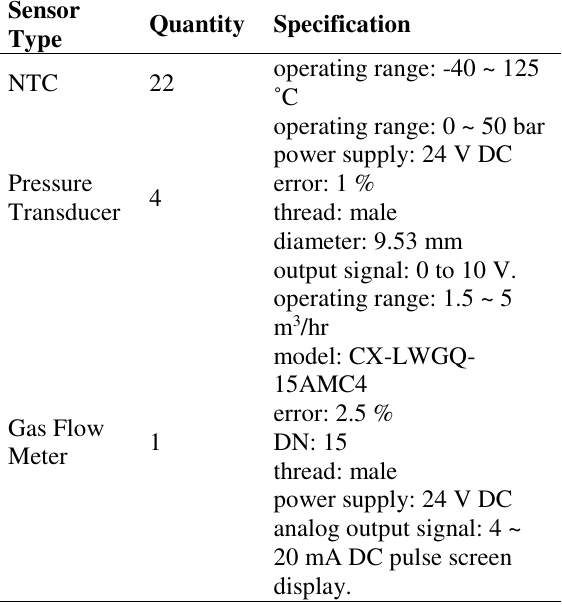
Specifications of measuring